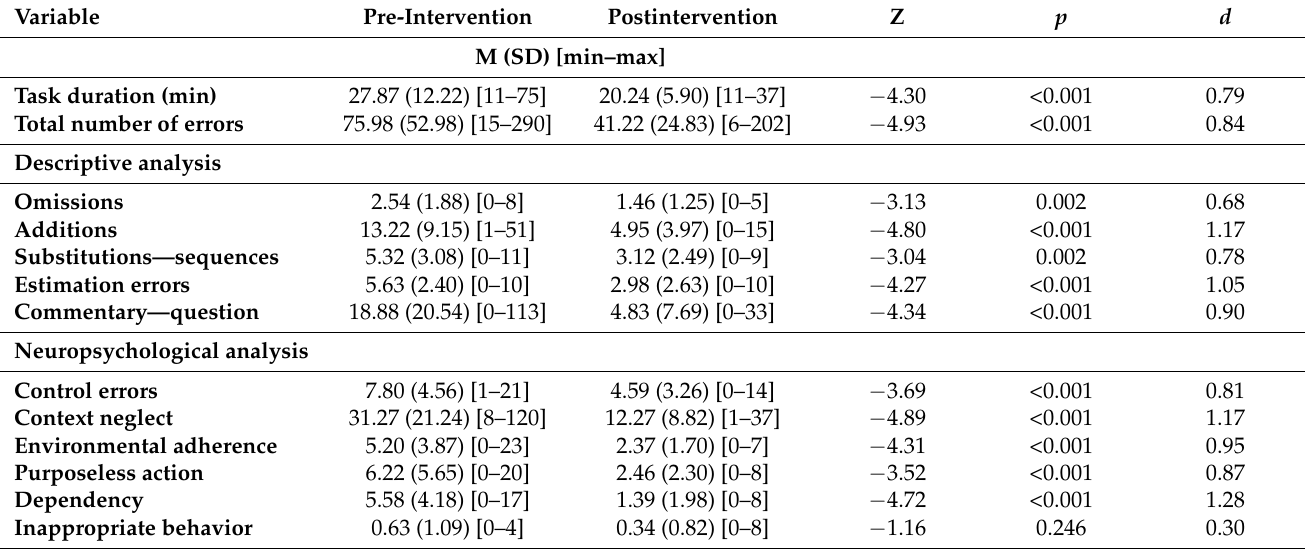
Table 1. Comparison of pre- and postintervention Children’s Cooking Task scores